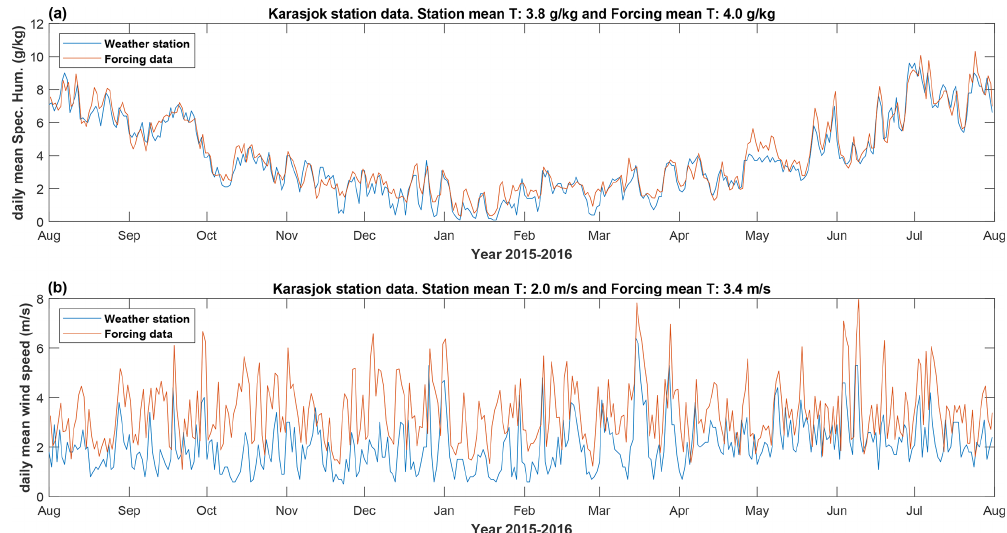
Figure A4. Comparison between the weather station and forcing data. (a) Specific humidity (grams of water vapor per kilogram of air). (b) Wind speed. The station is Karasjok-Markannjarga station, 131ma.s.l., 50km east from Šuoššjávri, which is 310ma.s.l. This station is located in an urbanized area with a higher surface roughness that likely promotes lower wind